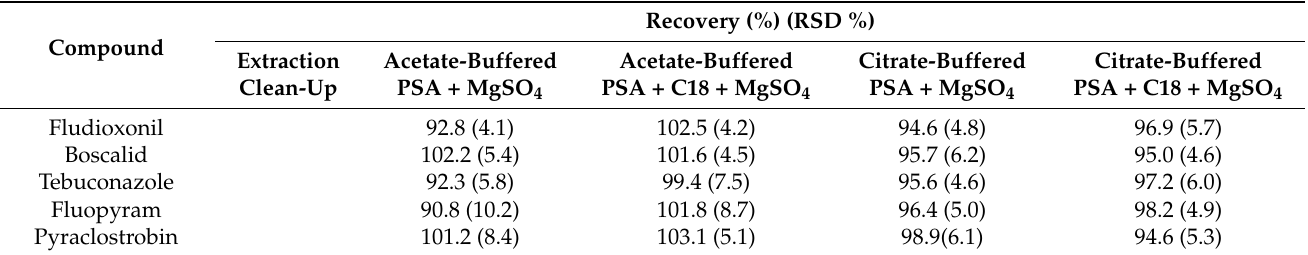
Table 1. Recovery of selected pesticides from different versions of QuEChERS at a concentration